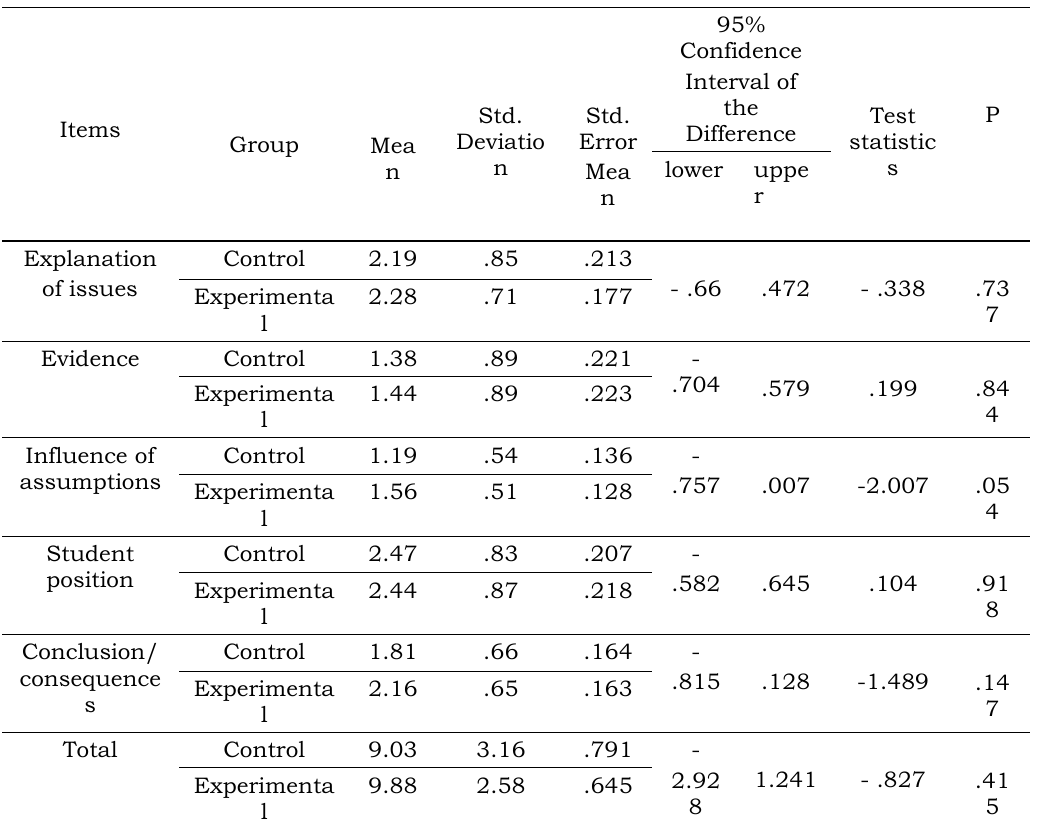
Table 2. Independent Samples Test for Opinion Essays of Control and Experimental Groups